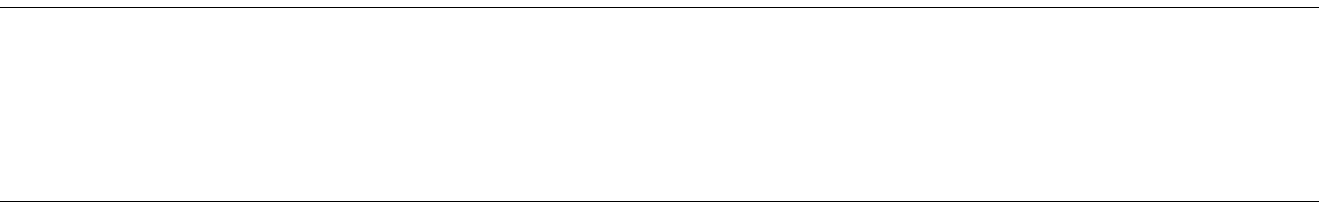
Table 3. Antibiotic prescriptions showing rates of dispension at pharmacy ( N = 31 265 RTI contacts with GP resulting in a prescription of an